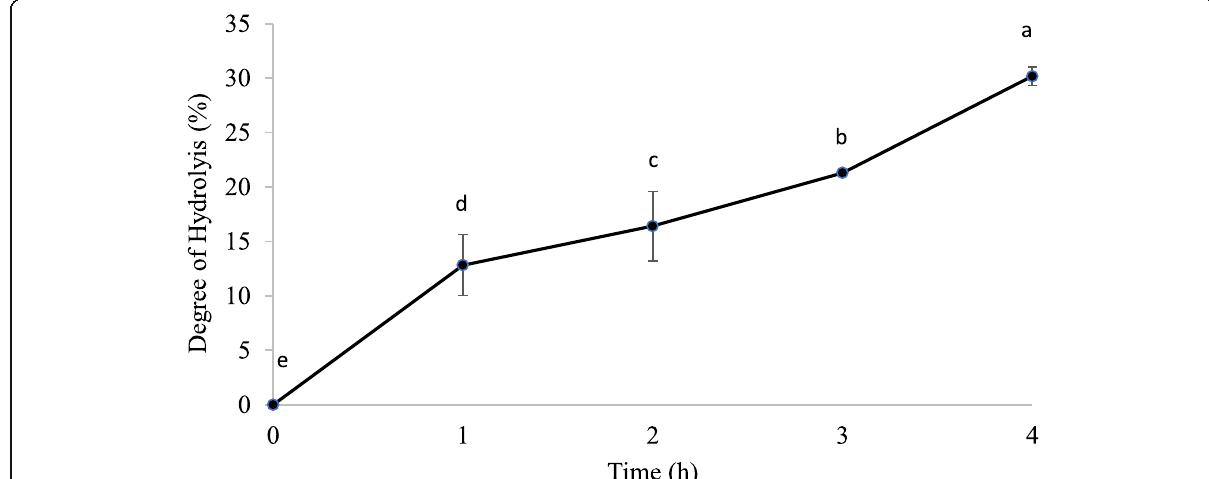
Fig. 2 Degree of hydrolysis (%) of canary seed protein over time, using a commercial protease (alcalase). Data points and error bars represent mean ± standard deviation of triplicate determinations. Different letters (a – e) indicate significant differences ( p < 0.05) between degree of hydrolysis